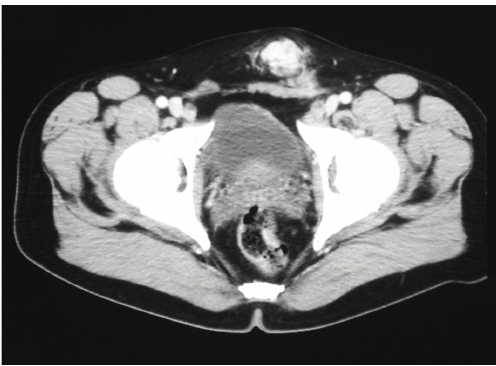
Figure 1: Round region of heterogeneously increased density in an- terior abdominal wall just superior to symphysis pubis. This region measures approximately 3cm in diameter. Postoperative inflamma- tory changes are noted just inferior to this region.